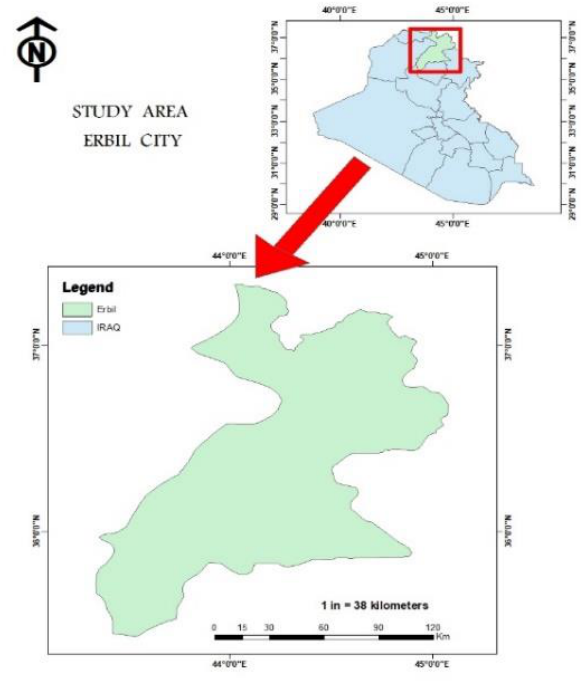
Figure 1. Shown Study Area of Erbil